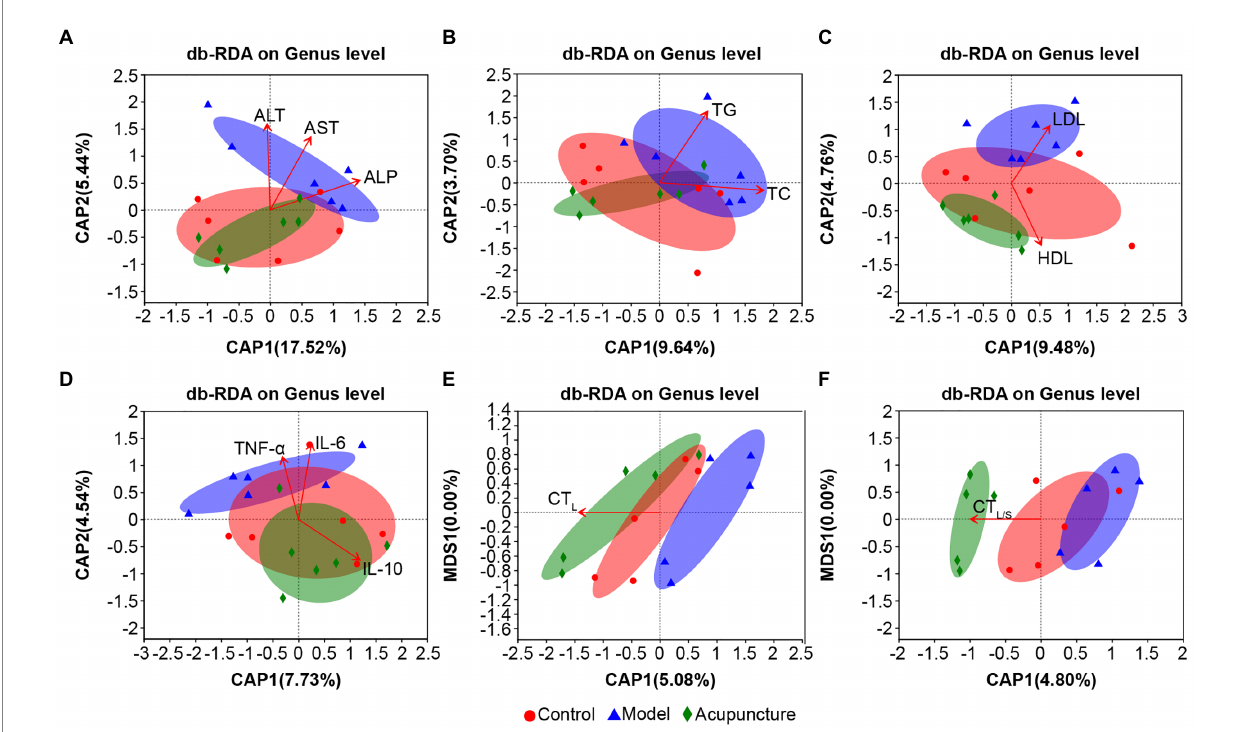
FIGURE 8 Distance-based redundancy analysis (db-RDA) on genus level of lipid metabolism parameters, inflammatory factors, and hepatic steatosis with intestinal microbiota. (A) Serum ALT, AST, and ALP. (B) Serum TC and TG. (C) Serum HDL and LDL. (D) Serum IL-6, TNF- α , and IL-10. (E) Liver CT (CT L ) values. (F) CT values of liver to spleen ratio (CT L/S ). The length of the red arrows represents the degree of the effect of serum lipid metabolism parameters, inflammation factors, and hepatic steatosis on the intestinal microbiota. The longer the arrow, the greater the correlation.